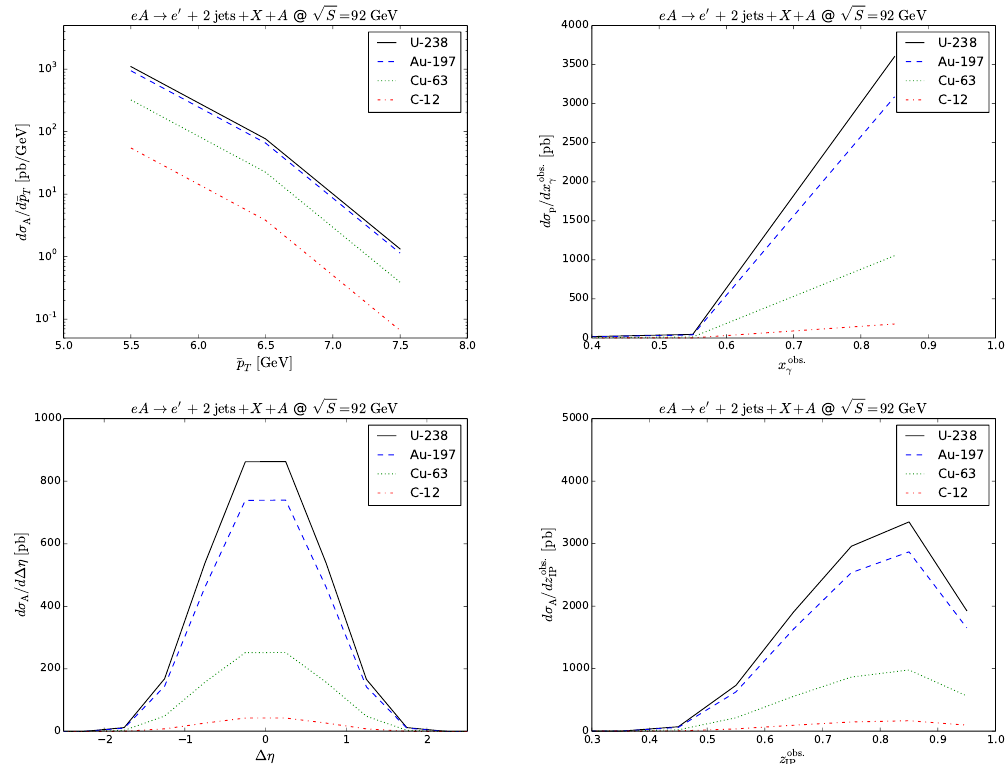
Figure 4: NLO QCD cross sections for coherent diffractive dijet photoproduction eA → e (cid:48) + 2 jets + X + A with various nuclear beams and a center-of-mass energy (cid:112) s = 92 GeV at the EIC. The cross sections are shown as functions per nucleon of of the jet average transverse momentum (top left) and rapidity difference (bottom left) as well as the longitudinal momentum fractions in the photon (top right) and pomeron (bottom